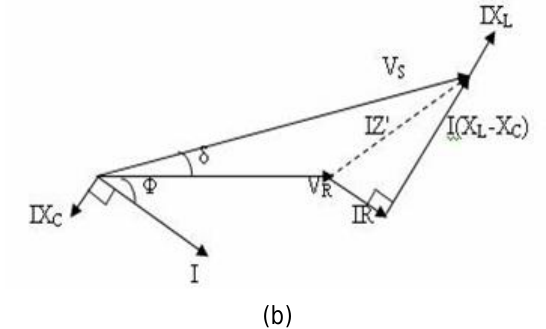
Figure 4. series compensated transmission line (a) single line diagram (b)phasor